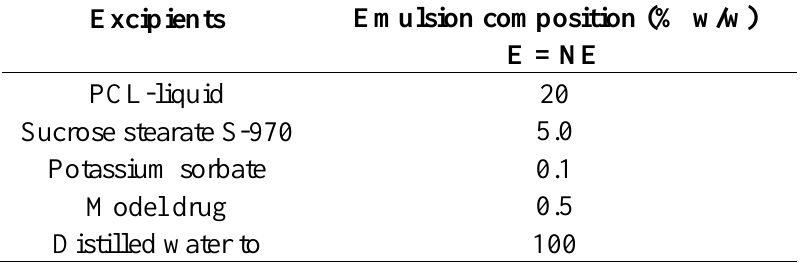
Table 1. Basic composition of macroemulsions (E) and nanoemulsions